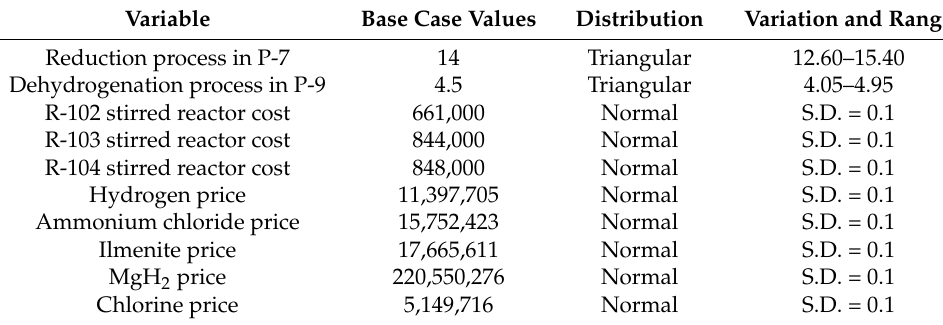
Table A8. Input parameters used for sensitivity